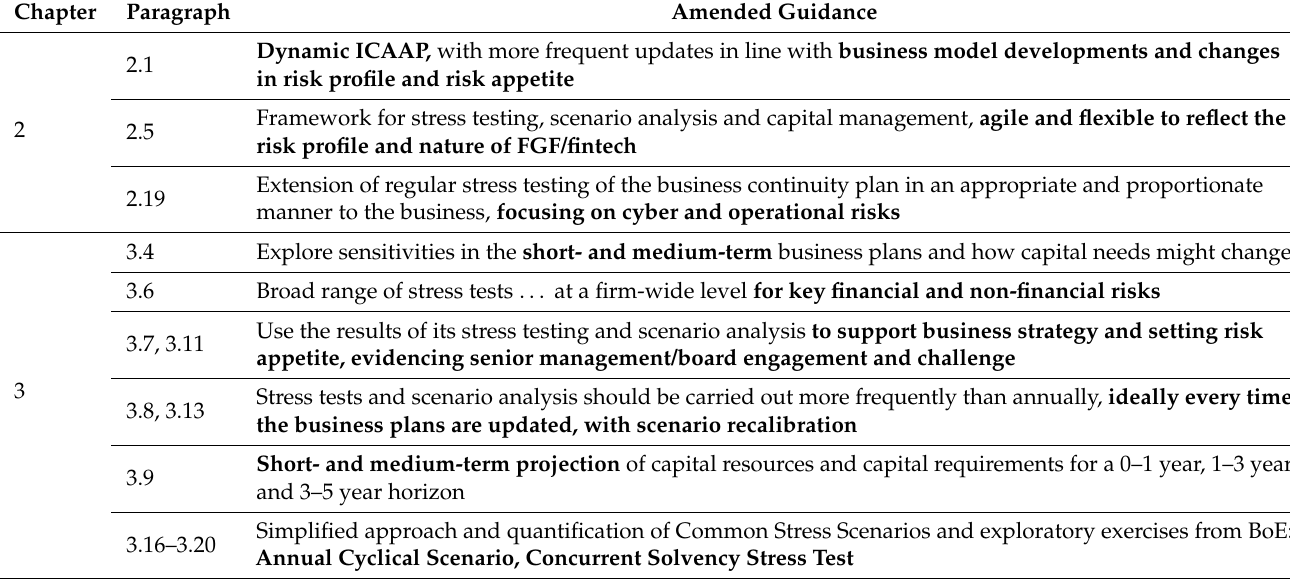
Table 2. PRA ICAAP Guidance Recommendations 8